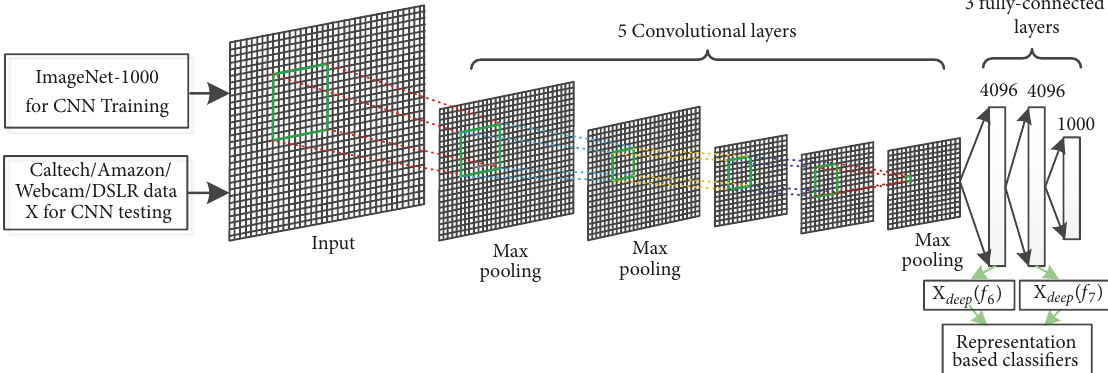
Figure 6: Diagram of the training and testing protocol in the experiment.